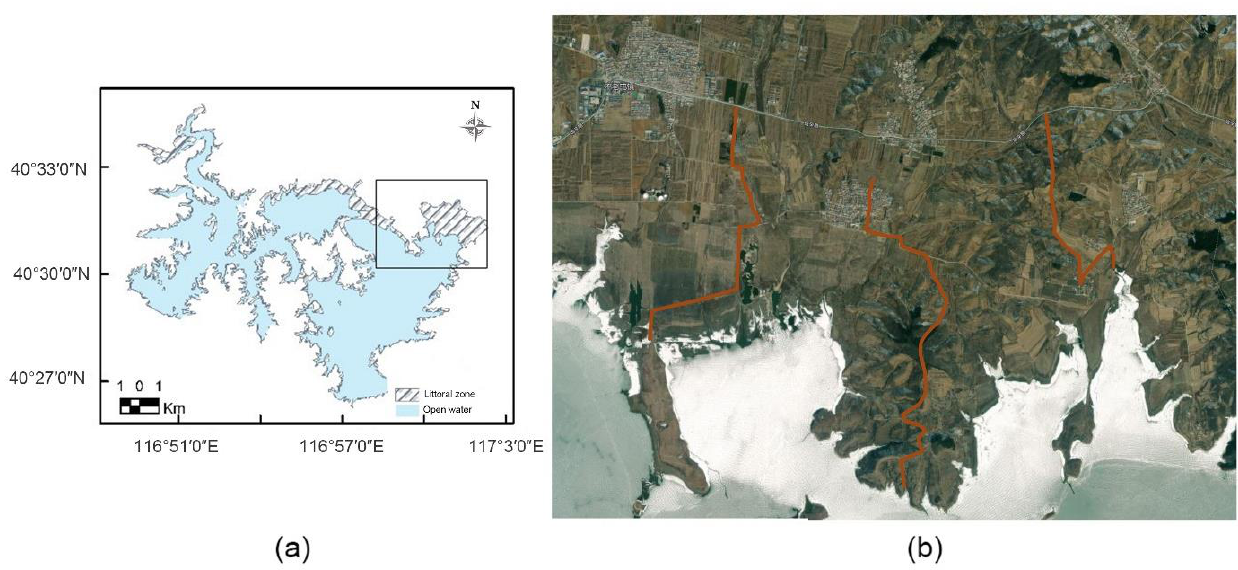
Figure 3. Survey area: ( a ) location of the Miyun Reservoir; ( b ) survey area and transect.